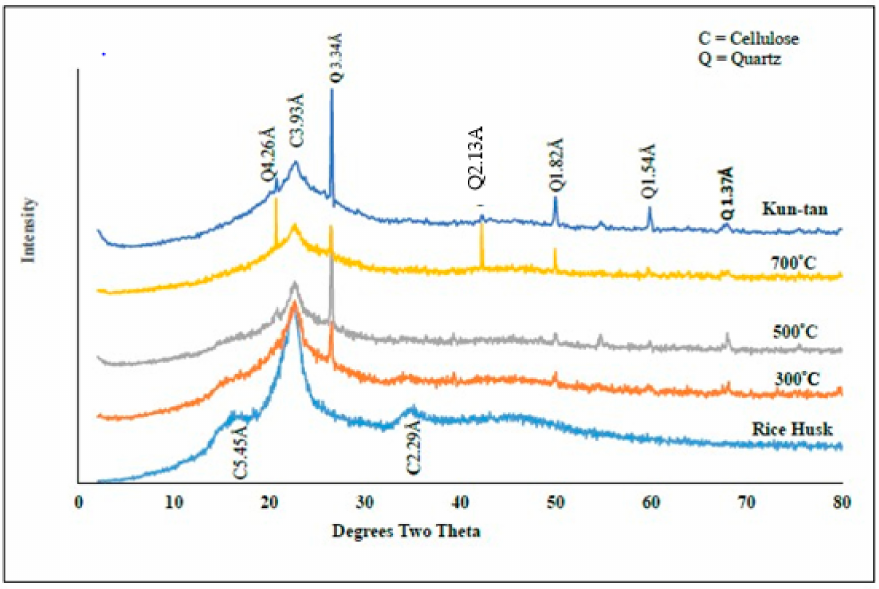
Figure 2. X-ray diffraction patterns of rice husk feedstock and rice husk biochar (RHB) pyrolyzed at 300 ◦ C, 500 ◦ C, and 700 ◦ C and by